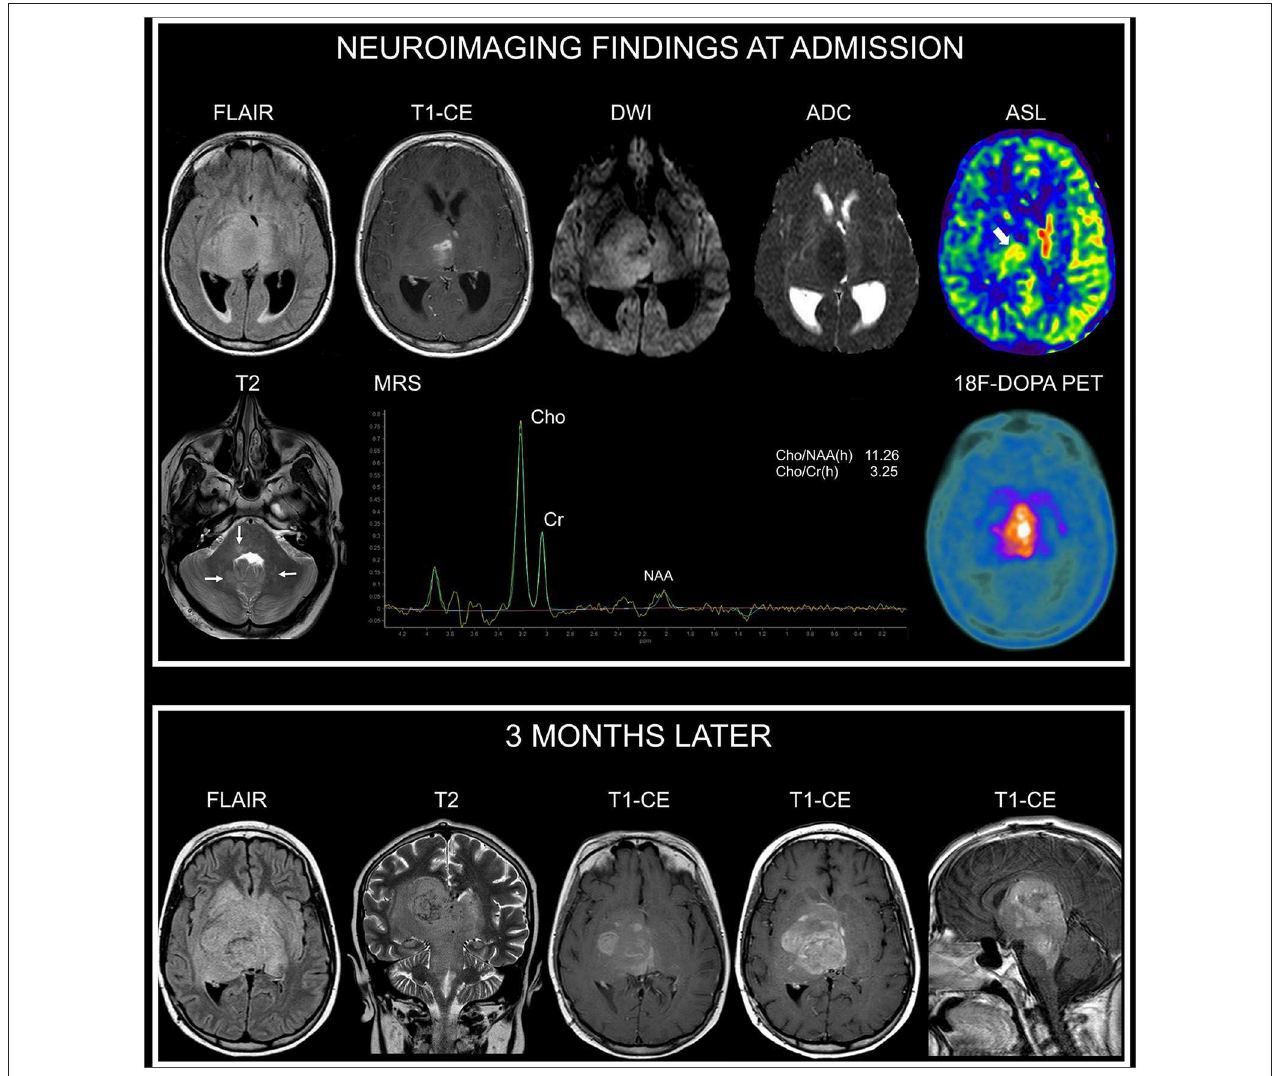
FIGURE 2 | Neuroimaging findings in NF1 patient 2. At admission, brain axial FLAIR and CE T1-weighted images show an infiltrating and expansile lesion with epicenter in the right thalamus, partially involving the contralateral thalamus, with irregular contrast enhancement. DWI and corresponding apparent diffusion coefficient (ADC) map show restricted diffusivity of the right thalamic portion of the lesion. Arterial spin labeling (ASL) perfusion-weighted imaging clearly demonstrates increased perfusion of the lesion (thick arrow). Axial T2-weighted image shows small focal hyperintense areas located in the dorsal pons and deep cerebellar white matter (thin arrows) in keeping with typical unidentified bright objects. Single-voxel MRS with an echo time of 144ms of the right thalamic region shows marked increase of Cho/NAA and of Cho/Cr ratios. 18F-DOPA PET clearly demonstrates markedly increased uptake of the lesion. Three months later, following radiotherapy and first-line chemotherapy treatment with temozolomide and vinorelbine, axial FLAIR and coronal T2-weighted images show increased extension of the infiltrating components in the deep cerebral regions with prominent involvement of the brainstem (midbrain and dorsal pons). Axial and sagittal CE T1-weighted images show concomitant marked increase of contrast enhancement. There was no evidence of leptomeningeal